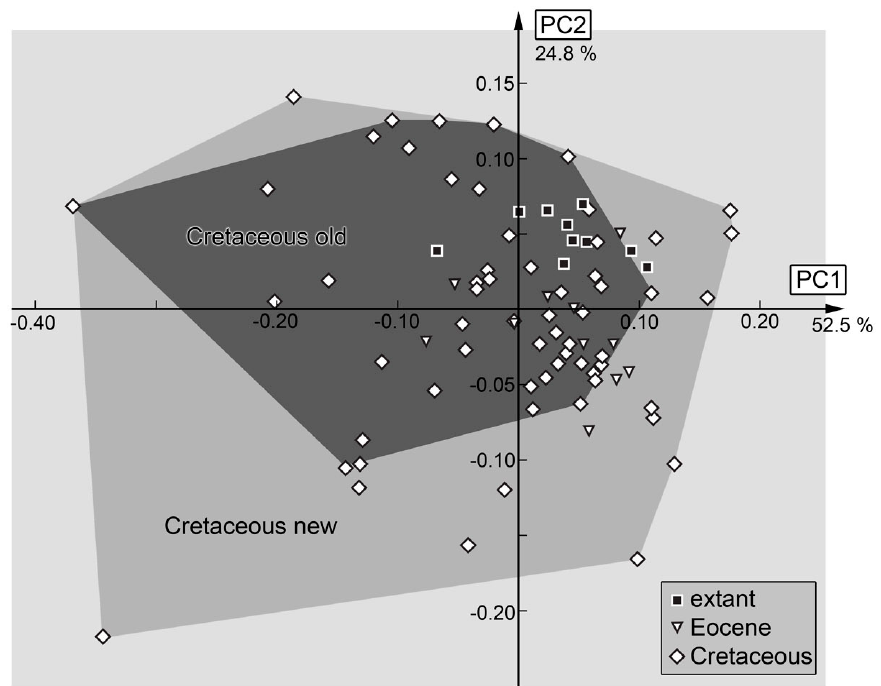
Figure 32. The same plot as in Figure 31, with area occupied by old specimens from Haug et al. [18] and combined area occupied by old and new specimens in comparison (see Supplementary Materials File S2 for details).